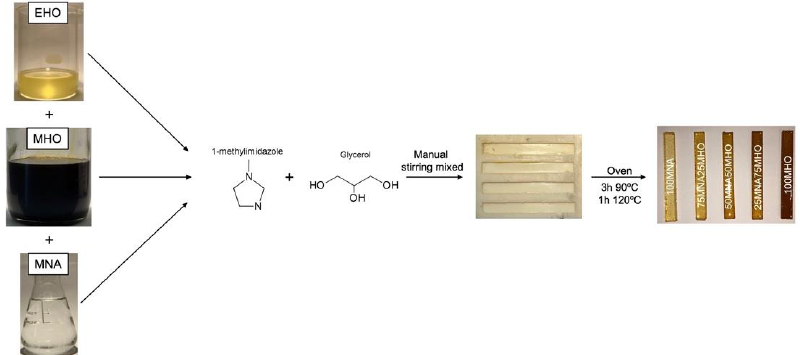
Figure 3. Diagram of sample preparation.